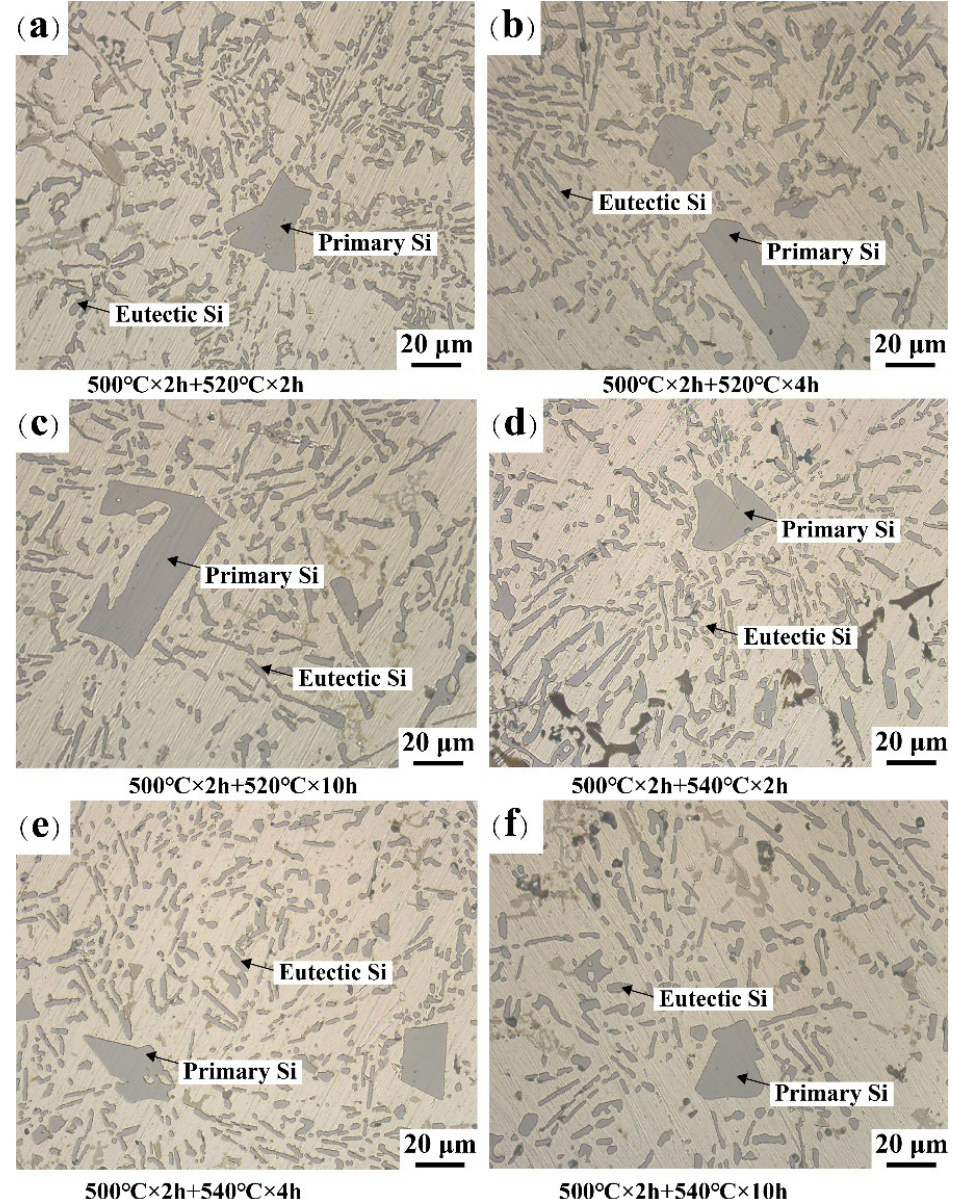
Figure 7. The optical micrographs of Al-Si alloys with different SHT: ( a – c ) 500 °C for 2 h and 520 °C, ( d – f ) 500 °C for 2 h and 540 °C.